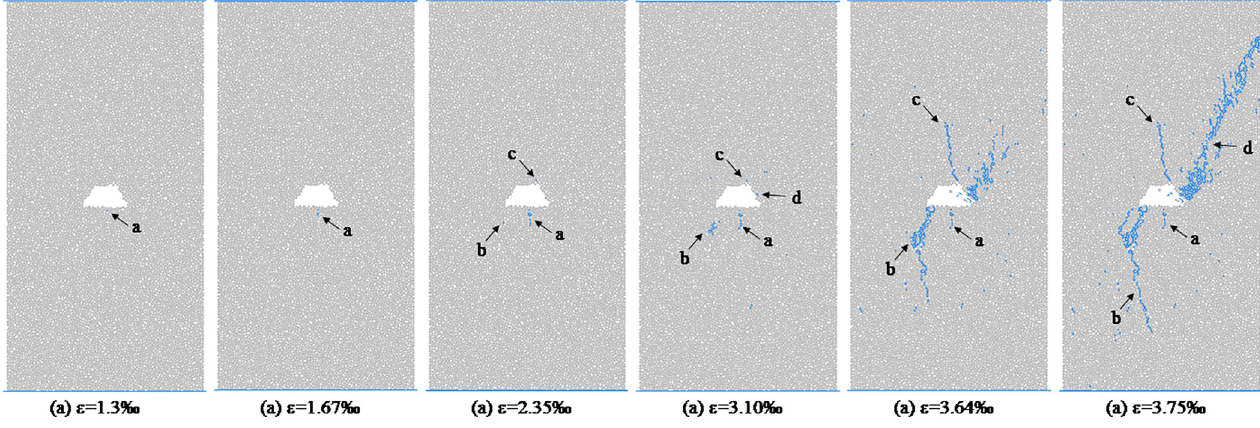
Fig 14. Meso-damage process of coal and rock with trapezoid hole